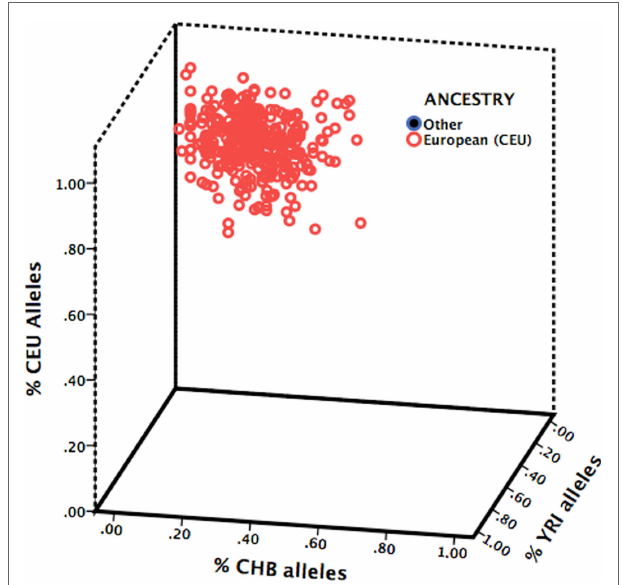
FigUre 1 | ancestry estimation of study sample . Participants were assigned to the HapMap ancestral group (Northern/Western European, CEU; Han Chinese, CHB; or Yoruba in Nigeria, YRI) for which they carried the greatest proportion of that population’s ancestry-informative markers.